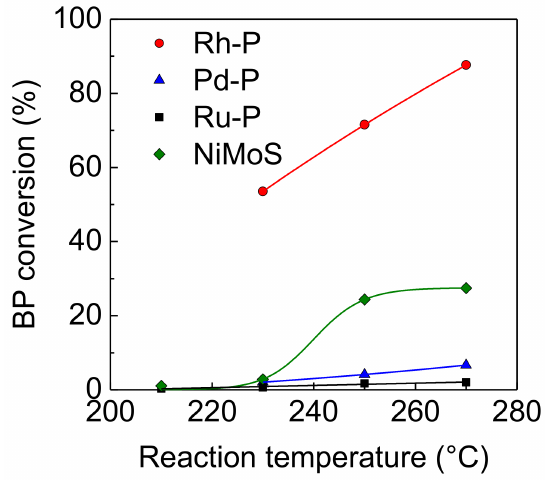
Figure 1. Effect of reaction temperature on activities of NM-P and NiMoS catalysts for hydrogenation of